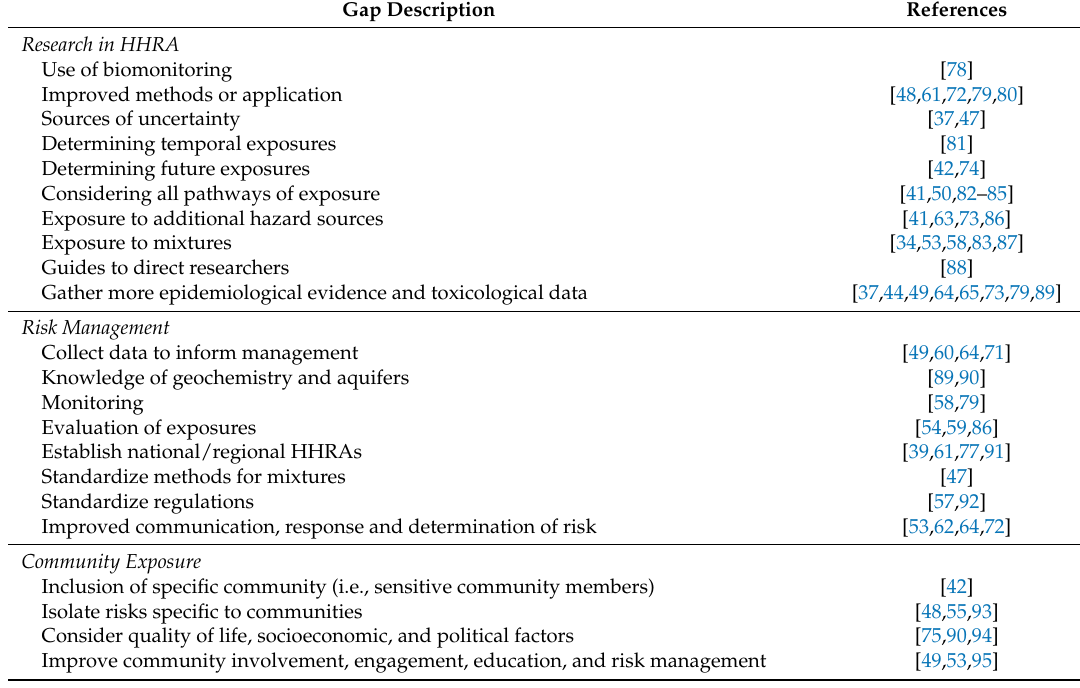
Table 4. Description and references for research, management, and community gaps identified in the scoping review literature ( n =